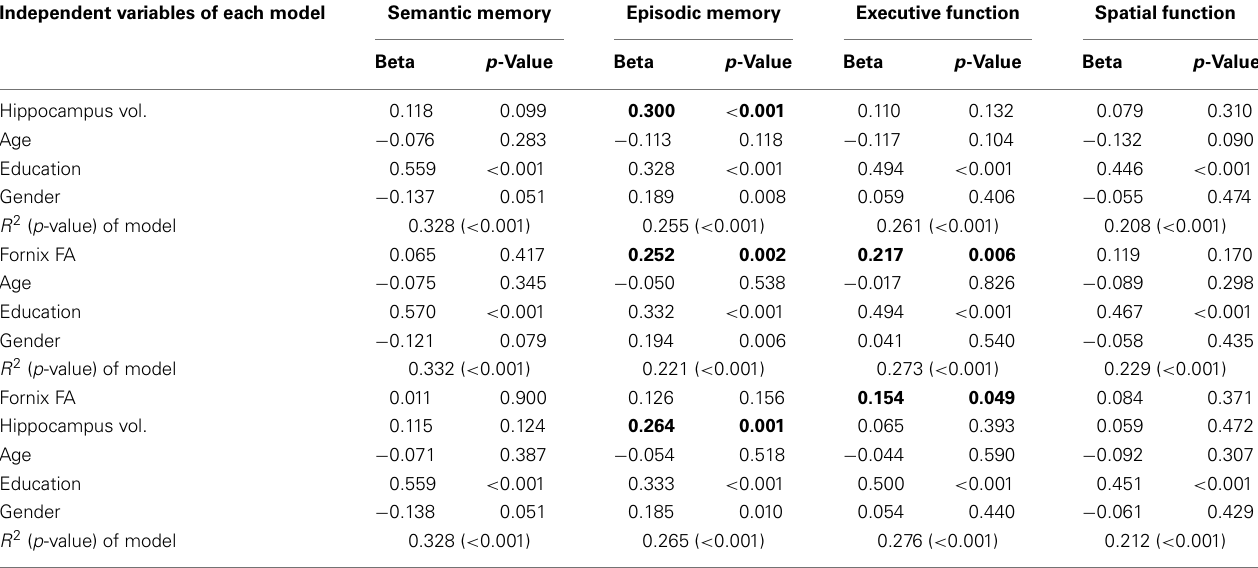
Table 2 | Multiple regression models explaining cognitive functions with hippocampus volume and fornix fractional anisotropy (FA). Independent variables of each